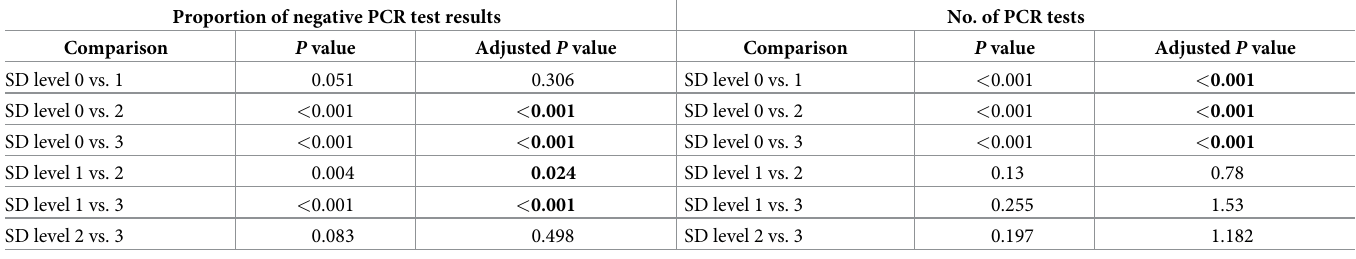
Table 2. Post hoc comparisons of the proportion of negative respiratory virus PCR test results and the number of respiratory virus PCR tests according to the levels of social distancing (SD) (levels 0, 1, 2, and 3) using the Mann-Whitney U test with Bonferroni correction. Proportion of negative PCR test